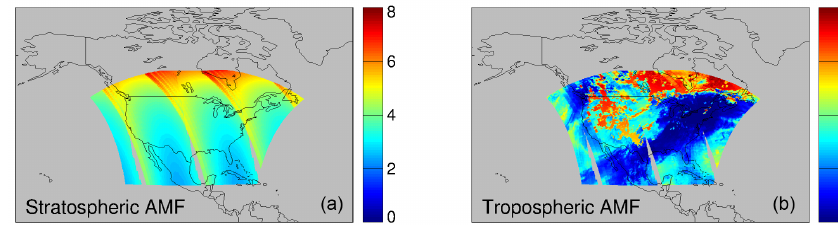
Figure 5. Stratospheric (a) and tropospheric (b) air mass factors for 15 January 2007.